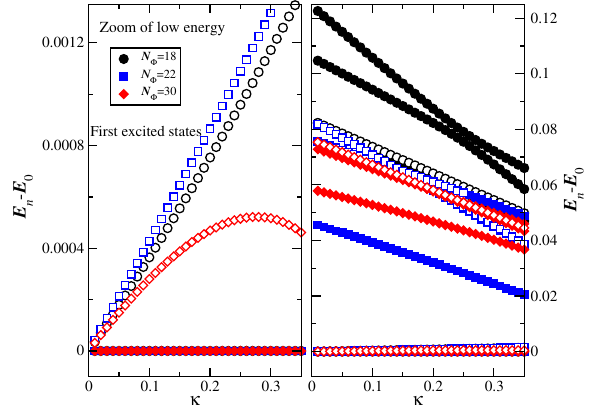
FIG. 12. The total energies relative to the ground-state energy on the torus using the hexagonal unit cell for N Φ ¼ 18 , 22, and 30 as a function of κ for w= l 0 ¼ 0 . Similar to Fig. 10, a state with h ϕ i < 0 has a filled symbol while a state with h ϕ i > 0 has an open symbol. The right panel shows the six lowest